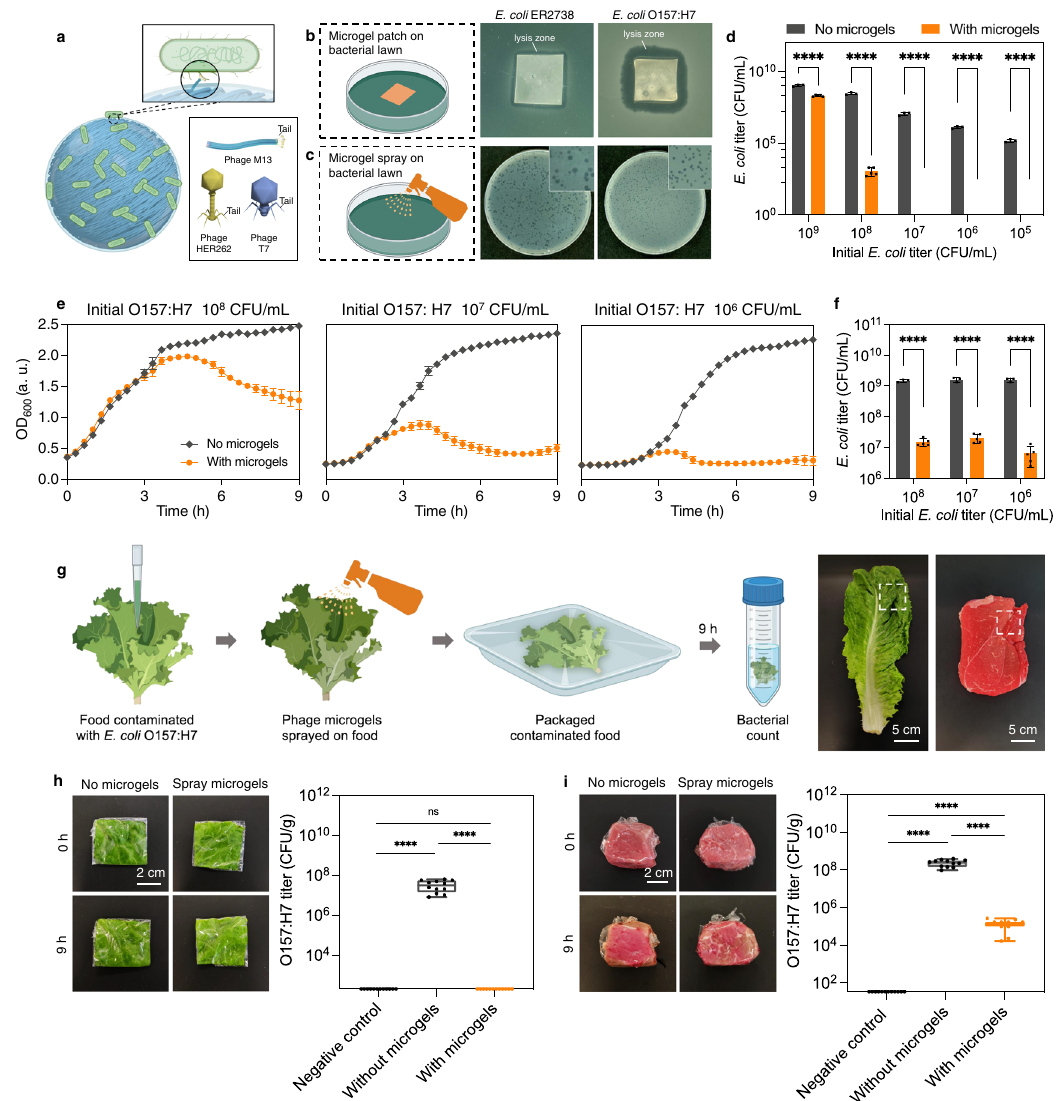
Fig.4|Antimicrobialactivityofhybridphagemicrogels.a Schematicimageofa phagemicrogelwheretheM13g3p isbindingto thetipoftheFpilusonthehost E. coli . Box on the bottom right: Comparison of the shapes of phage M13 ( fi la- mentous), HER262 (long tailed), T7 (short tailed). b Photos of the HER262- embedded hybrid phage microgels patcharrays forming lysiszones on the lawn of both E. coli ER2738 and E. coli O157:H7. c HER262-embedded hybrid phage micro- gels sprayed on the lawn of both E. coli ER2738 and O157:H7, showing clearing zones on both lawns. d Titer count of E. coli O157:H7 incubated in PBS after 9h at different initial concentration with ( n =5 independent experiments per bacterial concentration) and without ( n =3 independent experiments per bacterial con- centration) HER262 microgels.( p <0.0001 for all 5 bacterial concentrations). e Kill curves for E. coli O157:H7 suspension, incubated in TSB for 9h at different initial concentrationwithandwithoutHER262microgels( n =3independentexperiments per bacterial concentration). f Final titer count of the E. coli O157:H7 incubated in TSB with ( n =5independent experiments per bacterialconcentration) and without